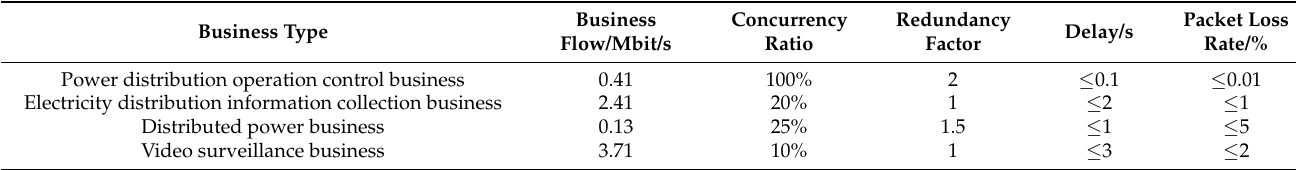
Table 4. Calculation table of communication service bandwidth in the intelligent distribution room.